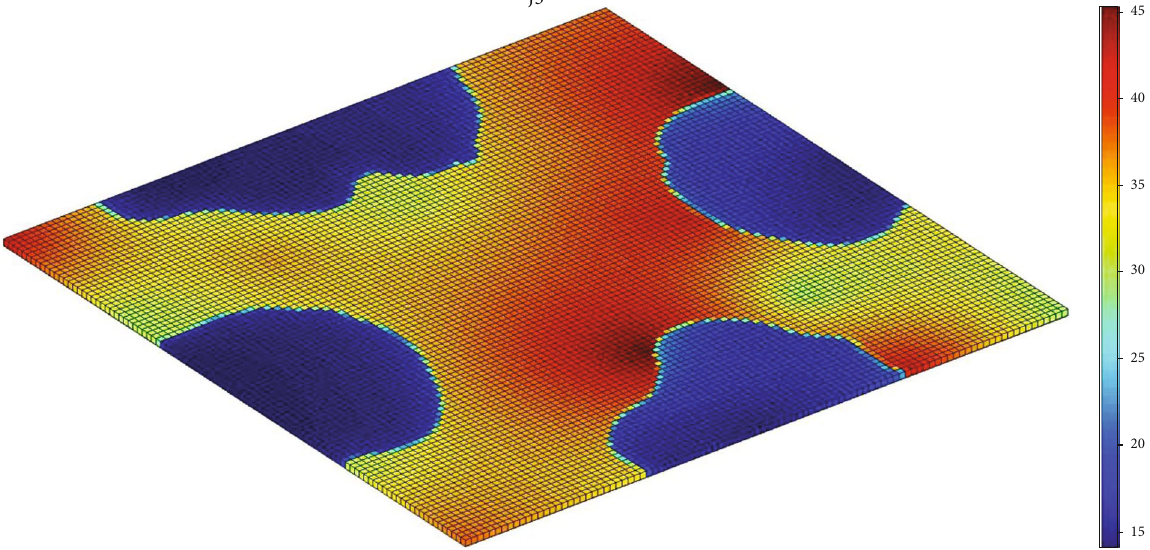
Figure 9: The reserve abundance of the 14 th layer.